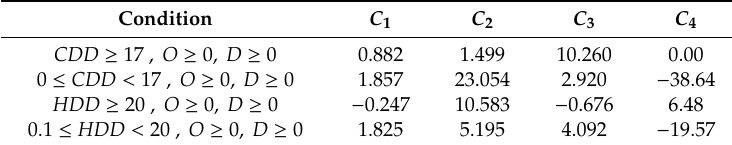
Figure 1. Block diagram of equation-based prediction system. Table 1. Coe ffi cients of Equation (1) determined by the MLR method.